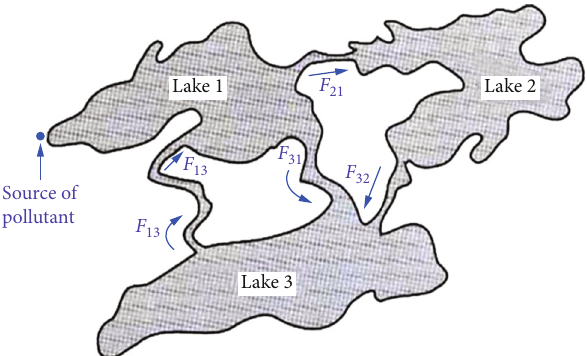
Figure 1: Interconnecting channels of the system of three lakes